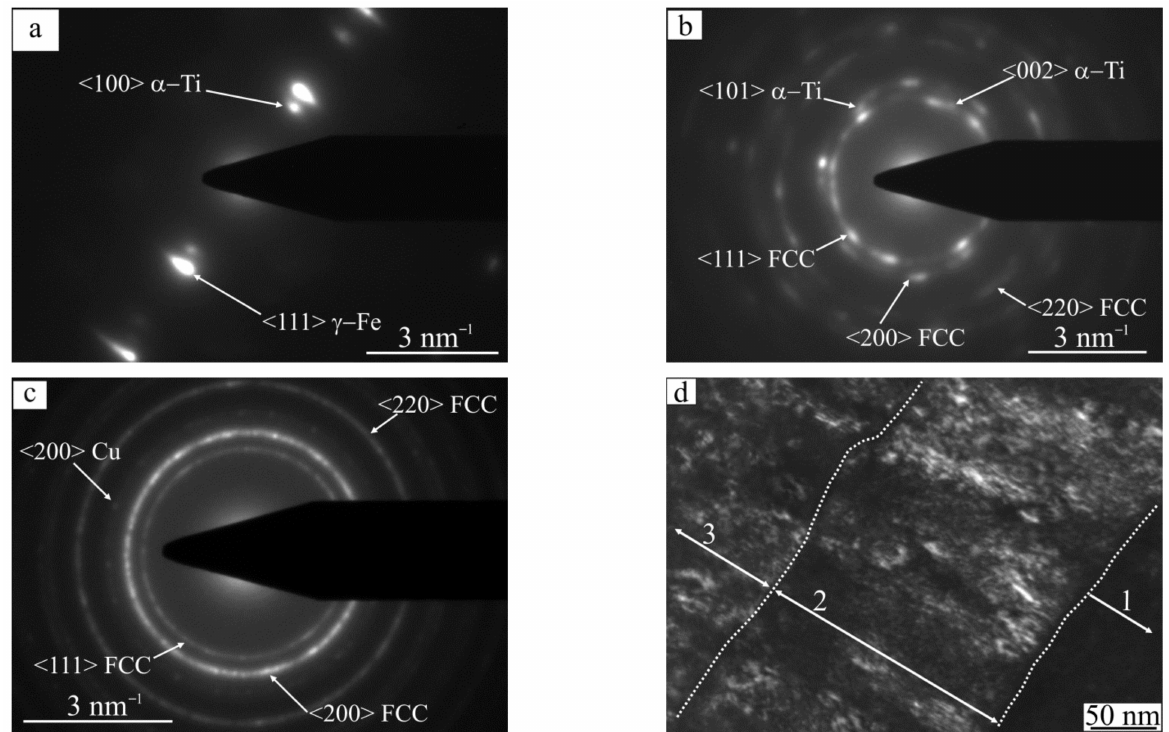
Figure 4. Microdiffraction electron patterns for the different coating layers ( a – c ) and the dark-field image ( d ) of columnar coating structure in reflexes <111> and <200> of TiN nitride (see notation in Figure